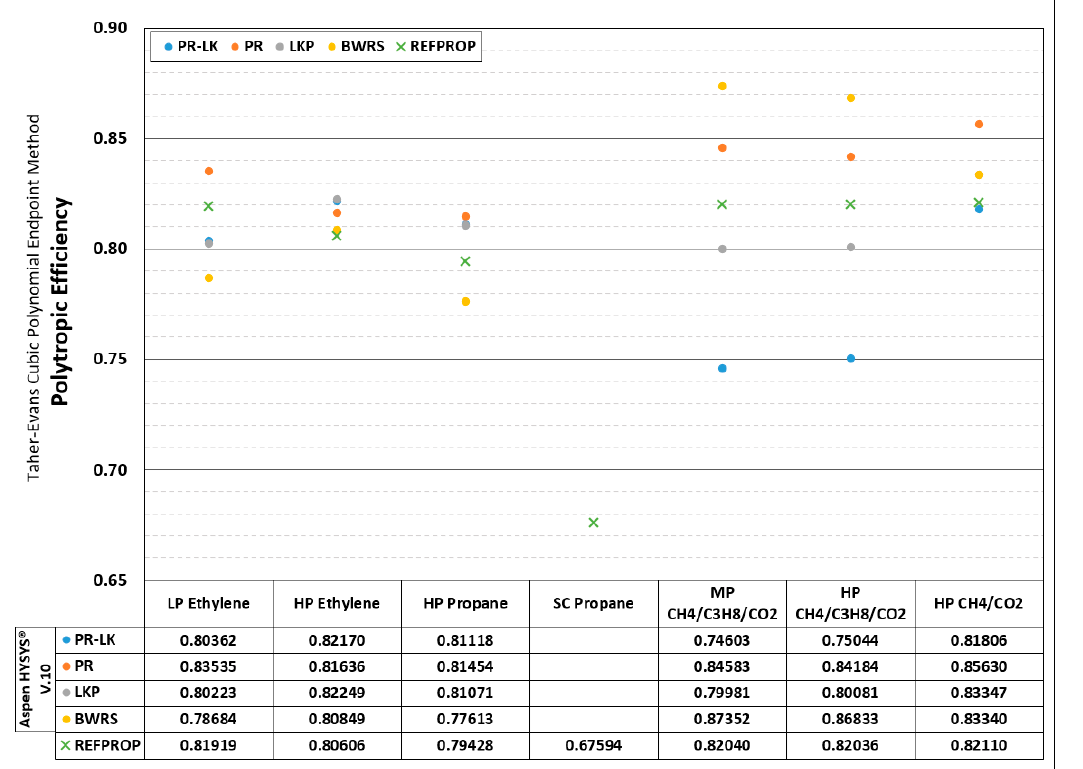
Figure A11. Variations of the calculated polytropic efficiency using different equations of state for seven example cases. Taher–Evans Cubic Polynomial endpoint method is used for the